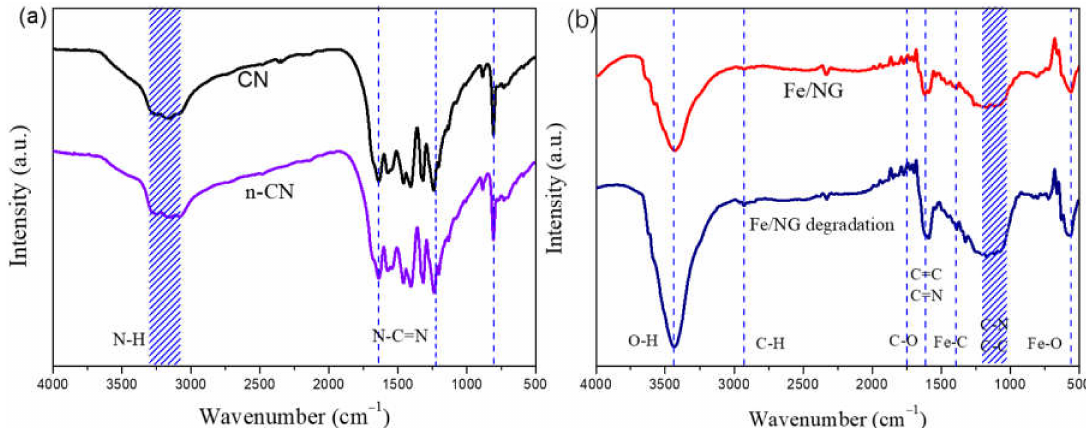
Figure 3. FT-IR spectrum ( a ) of CN and n-CN, spectrum ( b ) of Fe/NG and after the